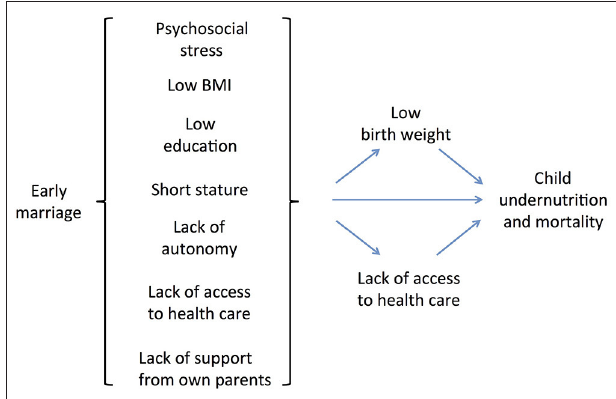
FIGURE 1 | Conceptual model of the pathways linking women’s early marriage to child undernutrition and mortality.